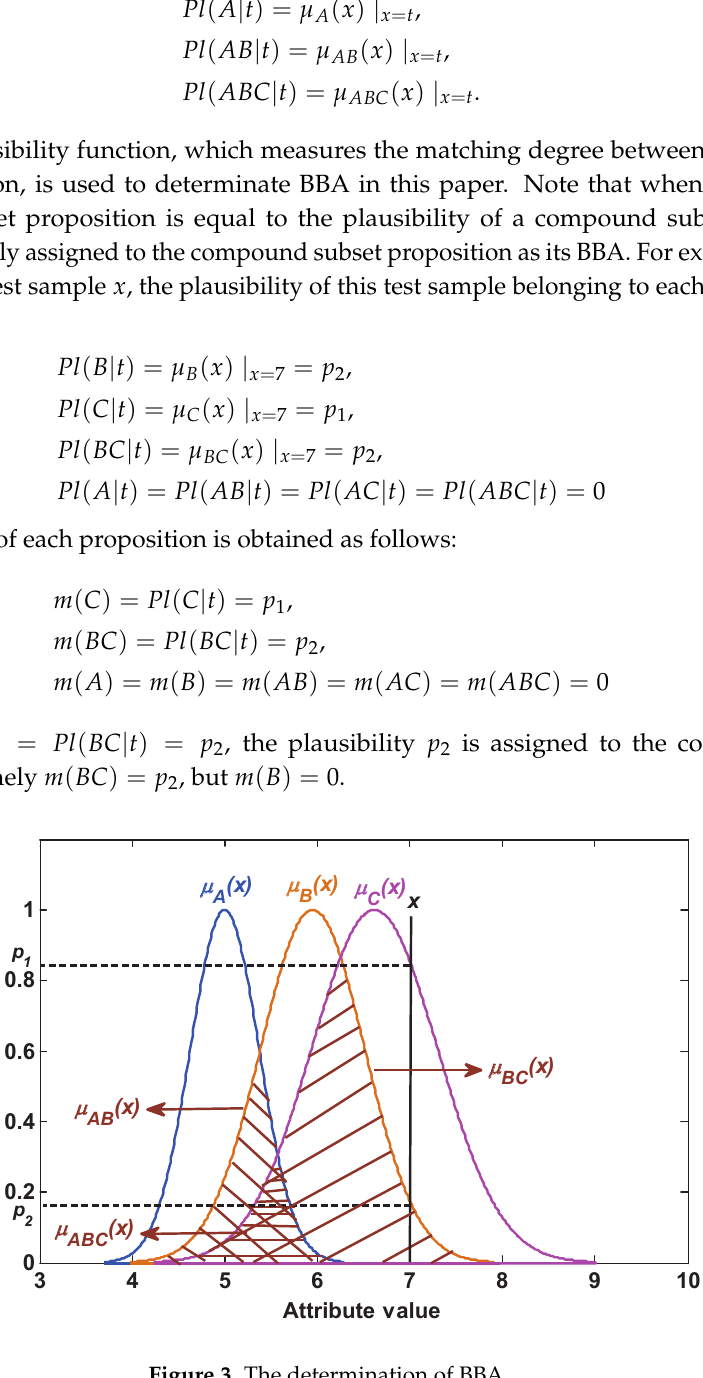
Figure 3. The determination of